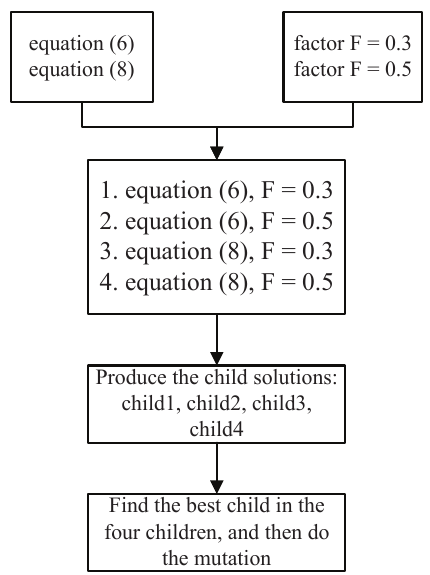
Figure 2. Flowchart of generating differential evolution (DE)